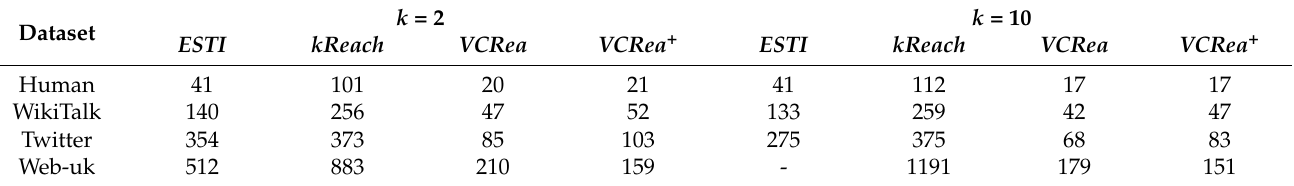
Table 5. Comparison of query time (ms), where d = 1 for the VCRea + algorithm.